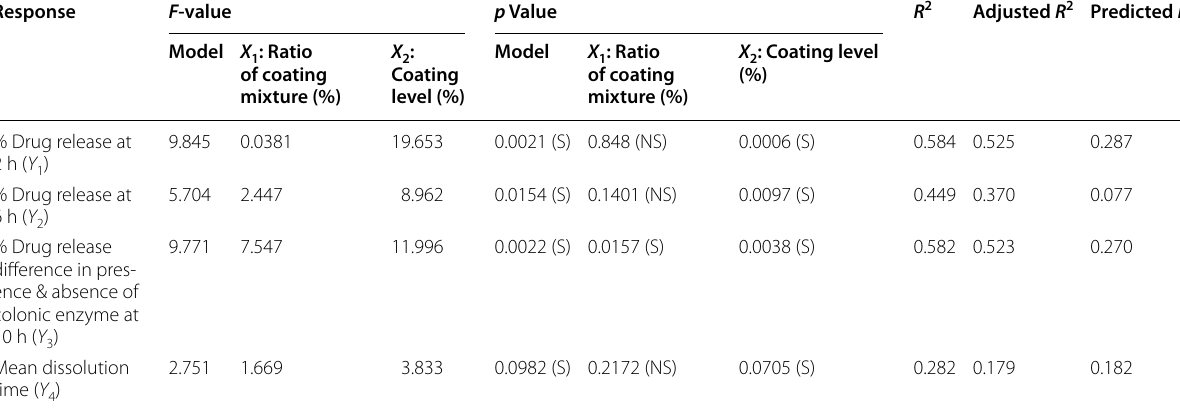
*Significant and non-significant value indicates by S and NS